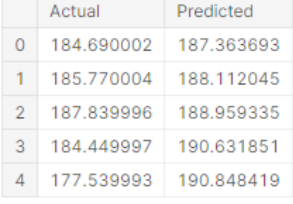
Figure 7. Prediction of Close price using CNN